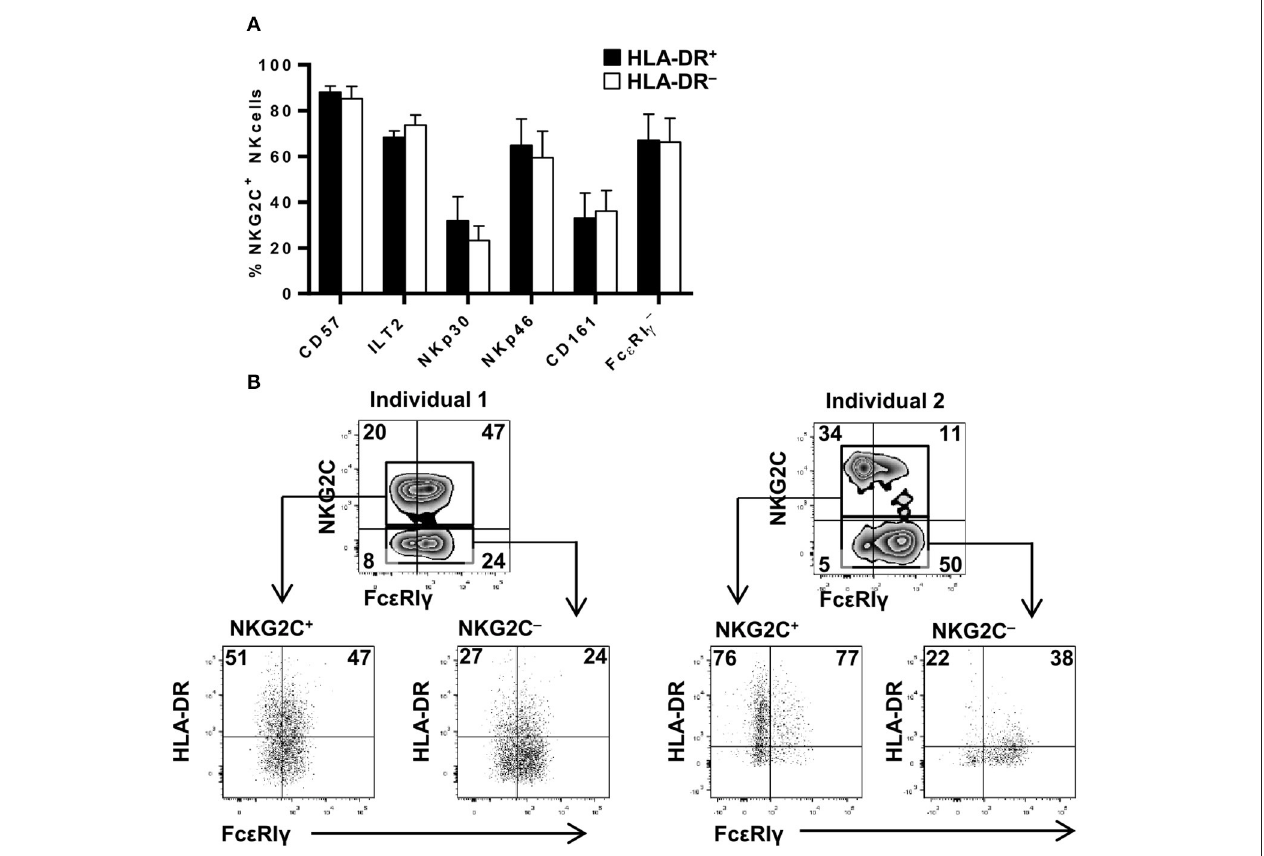
FIGURE 2 | HLA-DR expression in NKG2C + adaptive NK cells is uncoupled from phenotypic features associated to their differentiation profile. The expression of Fc ε RI γ , NKp30 and NKp46 NCRs, CD161, CD57, and ILT2 (LILRB1) was analyzed in NKG2C + HLA-DR + and NKG2C + HLA-DR– circulating NK cells from seropositive individuals with NKG2C + adaptive NK cell expansions. (A) Percentage of CD57, ILT2, NKp30, NKp46, CD161 positive, and Fc ε RI γ negative cells in CD56 dim NKG2C + NK cells according to HLA-DR co-expression (mean ± SEM, n = 5). (B) Expression of HLA-DR and Fc ε RI γ in NKG2C + and NKG2C– adaptive NK cells from two representative donors out of five studied. Inset numbers in lower panels indicate the proportions of HLA-DR in Fc ε RI γ + and Fc ε RI γ -NK cells.